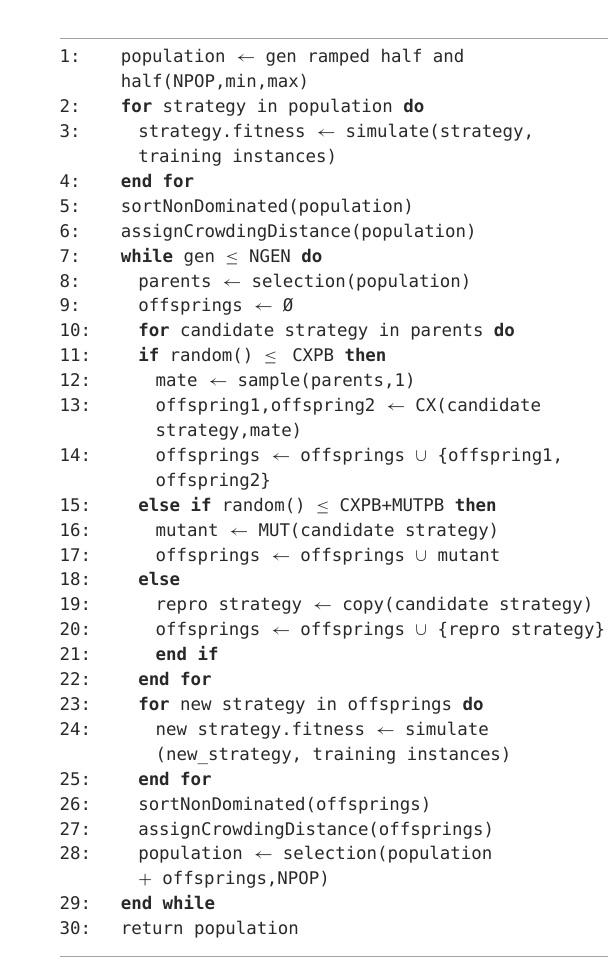
Algorithm 1. Bi-objective Evolutionary Learning